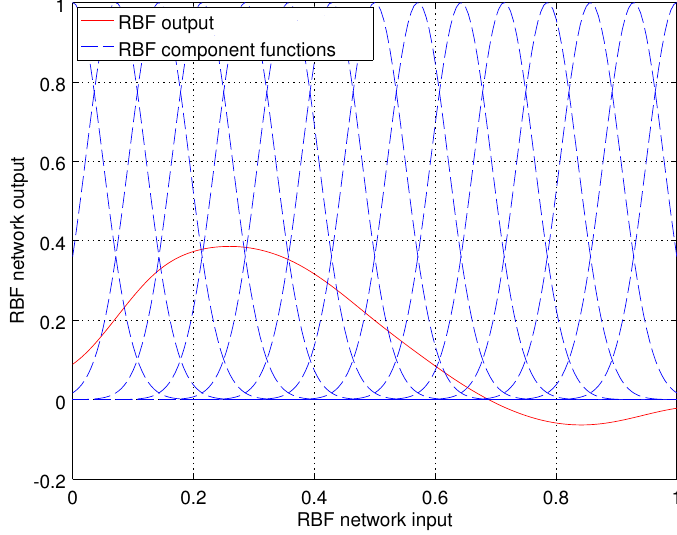
Figure 1. RBF network example providing ψ j as a function of v 1